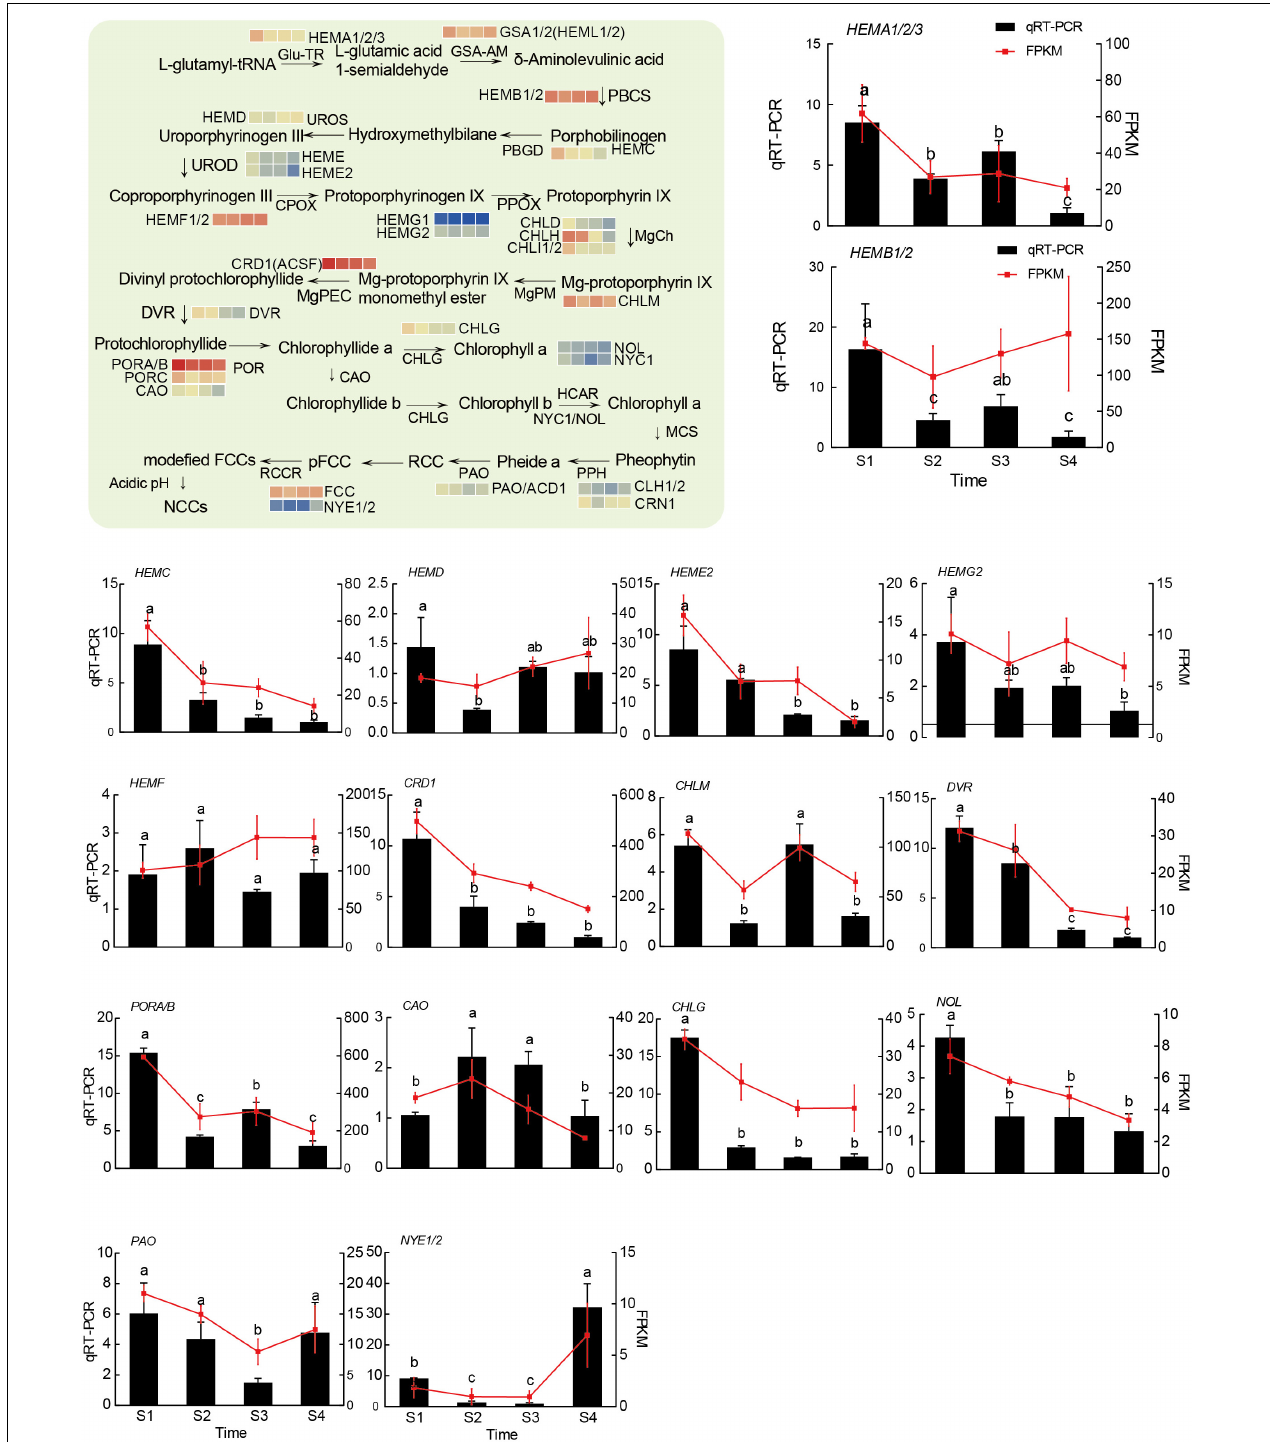
FIGURE 5 | The model diagram of the main chlorophyll biosynthesis pathway, and transcriptional analysis of and qRT-PCR assays of 16 genes related to chlorophyll biosynthesis. R-package heatmaps were used to plot the expression heatmap of these genes. The heatmap data were homogenized by log2 (FPKM). The relative expression levels of target genes were calculated based on the 2 − (cid:49)(cid:49) Ct method against the internal control, and the CcUBC9-5 gene was used as a control. Experiments were performed with three independent biological replicates and three technical replicates. Different letters showed significant differences ( P < 0.05, Tukey’s HSD) by ANOVA among